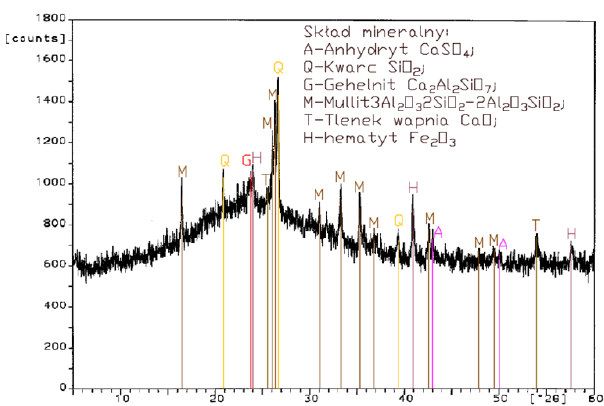
Figure 1. XRD pattern of conventional fly ash (CFA) from combustion of hard coal.